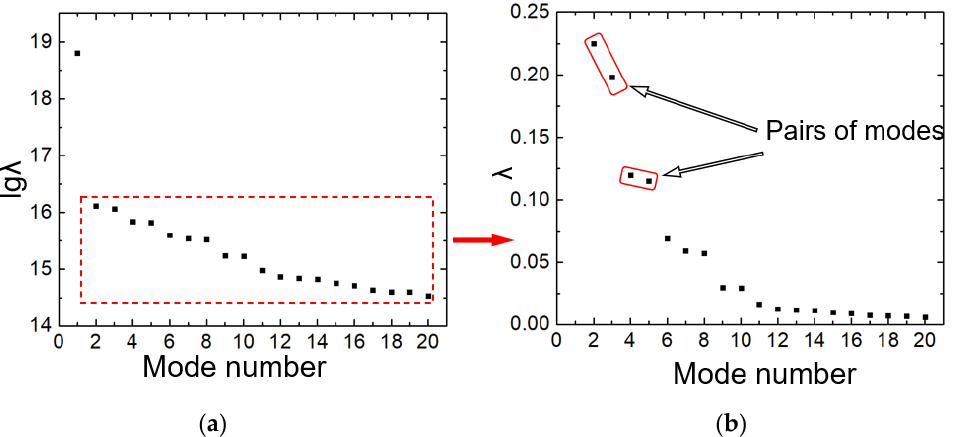
Figure 18. Distribution of eigenvalues for each rank of mode. ( a ) Logarithmic eigenvalue. ( b ) Nor- malized eigenvalue except Mode 1.